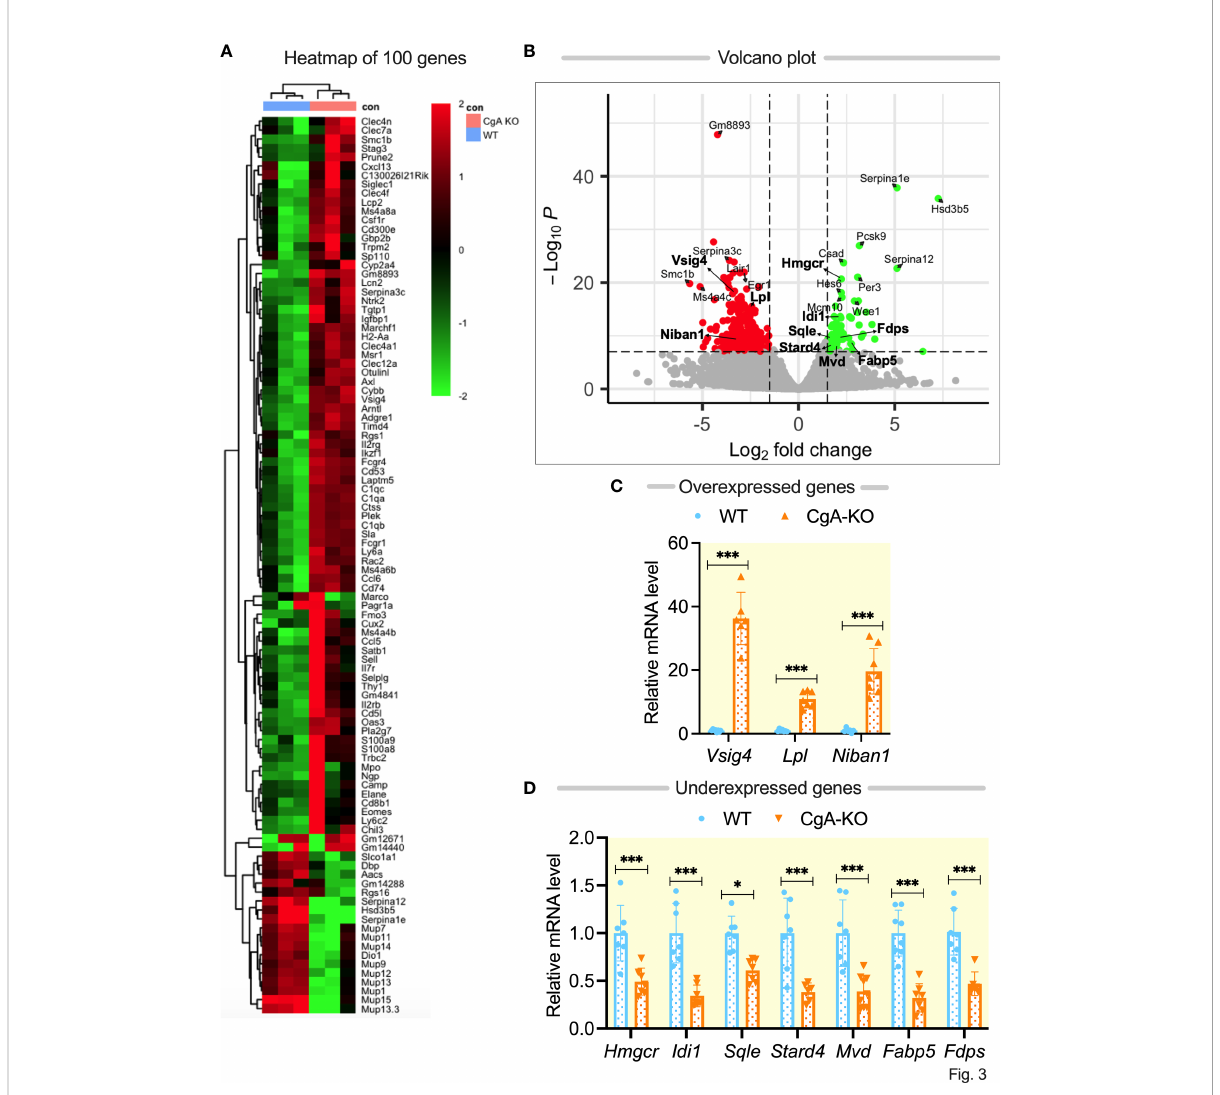
FIGURE 3 RNA sequencing of liver genes followed by q-RT-PCR validation of selected genes. (A) Heat map showing differentially expressed top 100 genes in WT and CgA-KO mice. (B) Volcano plot showing expression (over- and under-expression) of selected genes. (C) q-RT-PCR validation of selective overexpressed genes in CgA-KO mice as compared to WT mice. (D) q-RT-PCR validation of seven under-expressed genes in CgA-KO mice compared to WT mice. *P <0.05; ***p